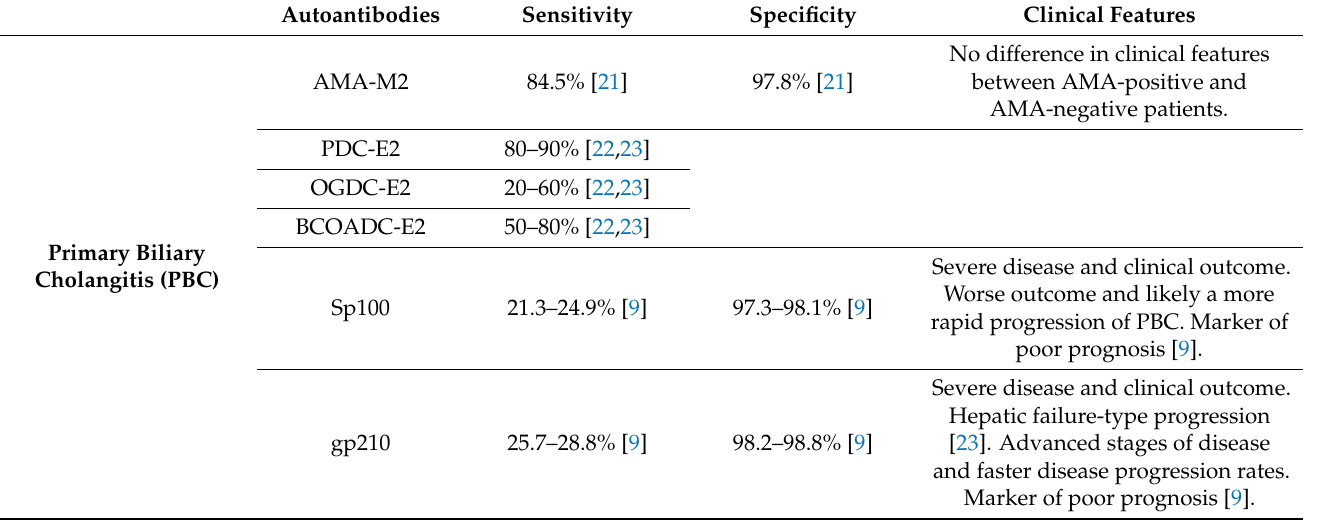
Table 1. Clinical significance of autoantibodies detected in AIH and